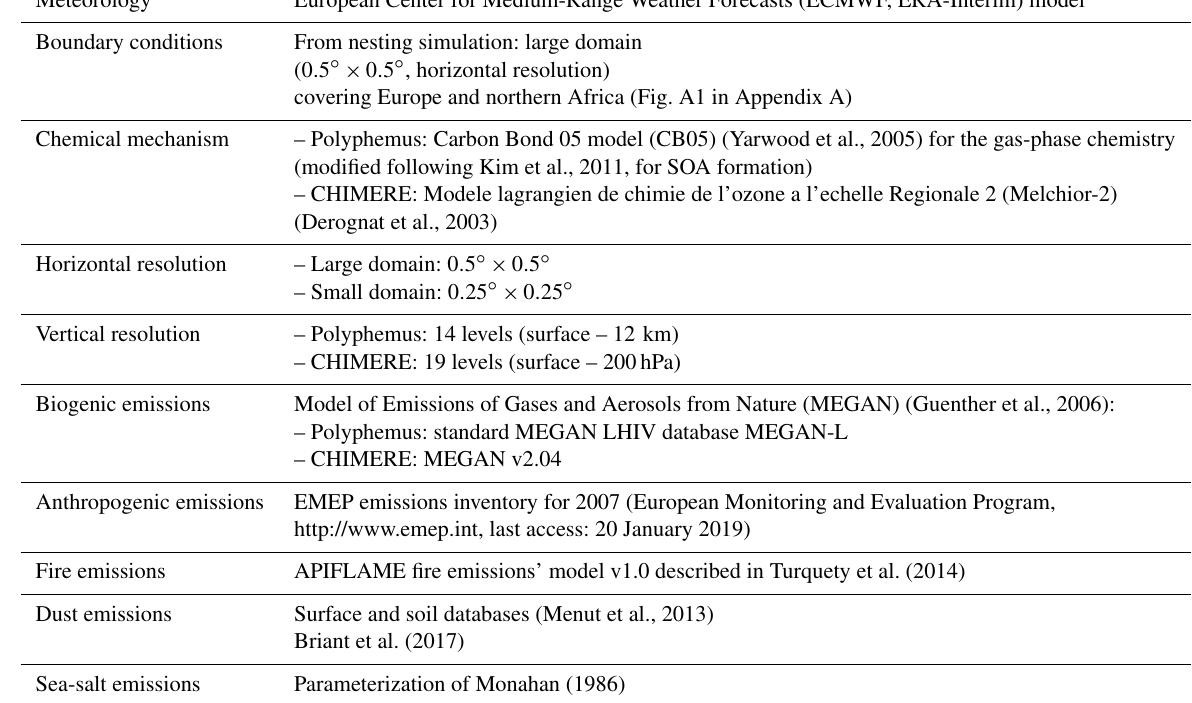
Table 1. Main characteristics of the Polyphemus and CHIMERE simulations.